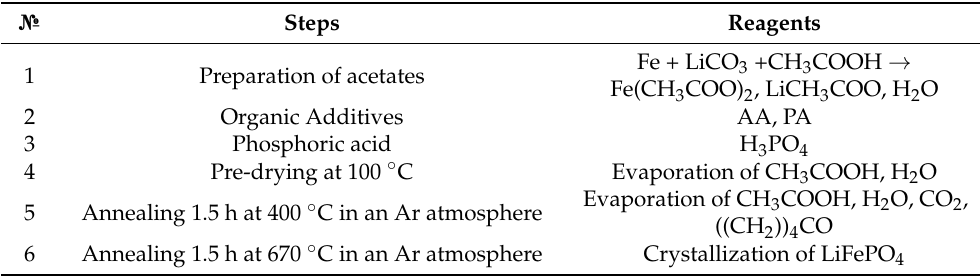
Table 1. Sequence of LiFePO 4 liquid-phase